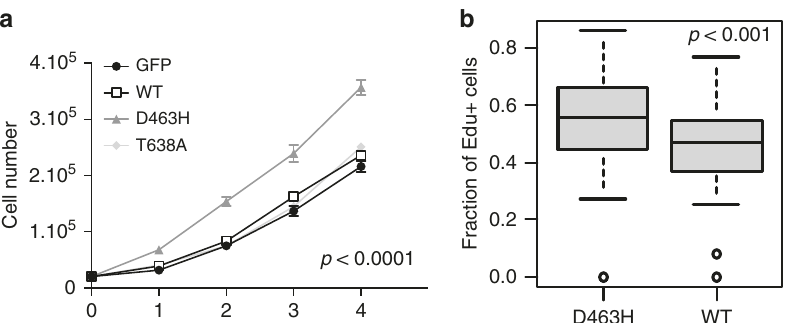
Fig. 3 Effect on cell proliferation. a PRKCA D463H mutation enhances proliferation of human astrocytes. Human immortalized astrocytes overexpressing PKC α D463H -Myc grow signi fi cantly faster ( p < 0.0001; ANOVA) than astrocytes overexpressing PKC α WT -Myc, PKC α T638A -Myc, or GFP. This analysis was performed from duplicate plates. b Primary rat tanycytes transduced with PRKCA D463H have a higher DNA replication rate than those transduced with PRKCA WT . Myc-positive cells, and Myc-positive – EdU-positive cells were counted. Results are from three independent experiments. The boxplots indicate the median with the box bounded by the 25 and the 75